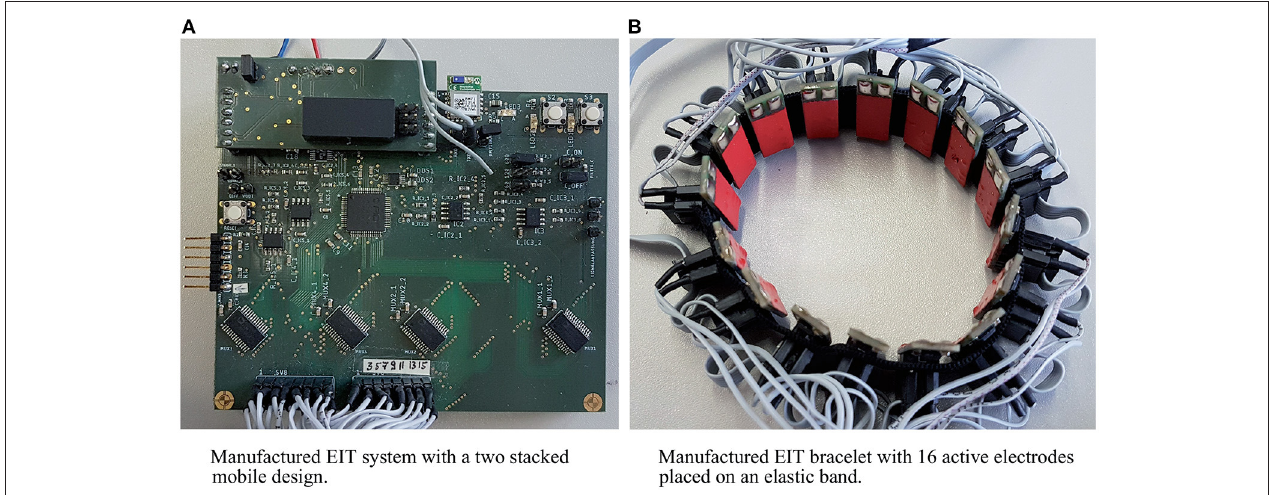
FIGURE 2 | EIT system used to record the data analyzed in this work: The central control unit (A) controls the current injection and voltage measurement. The electrode ring with 16 electrodes (B) exhibiting protective pads (red) and two silver pads indicating separate electrodes for current injection and measurement.